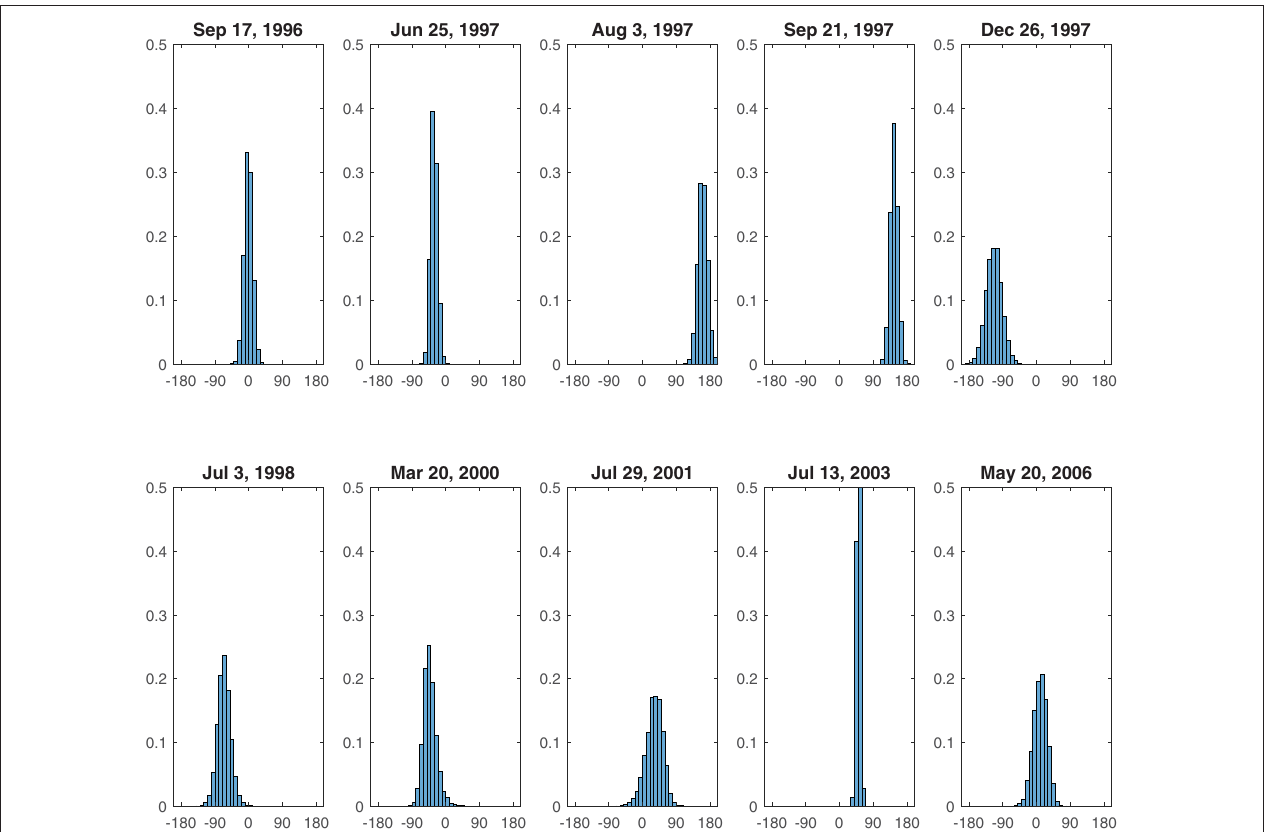
µ e . Each histogram is centered at 0 ◦ , due East. Note these are much narrower than { }